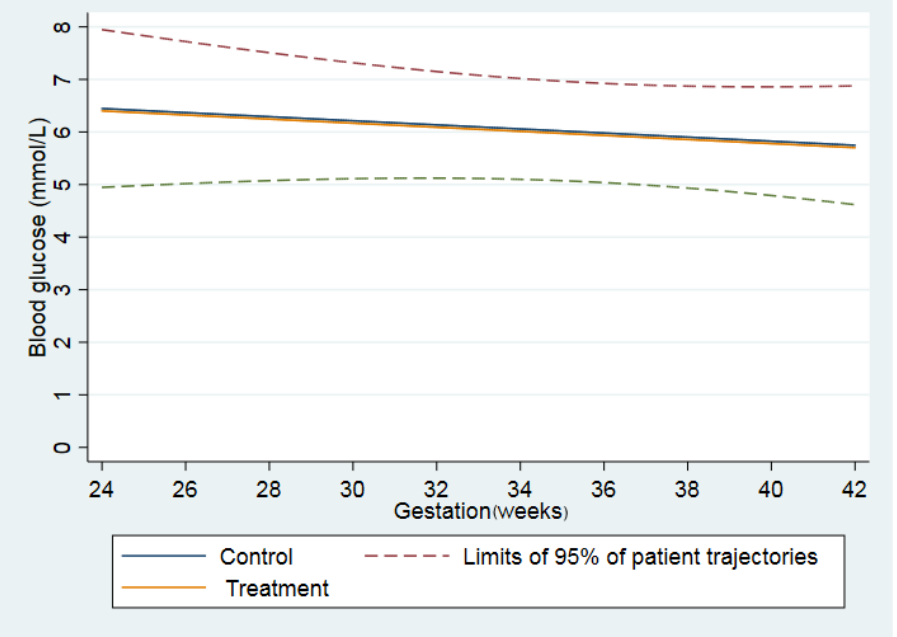
Figure 2. Change in mean blood